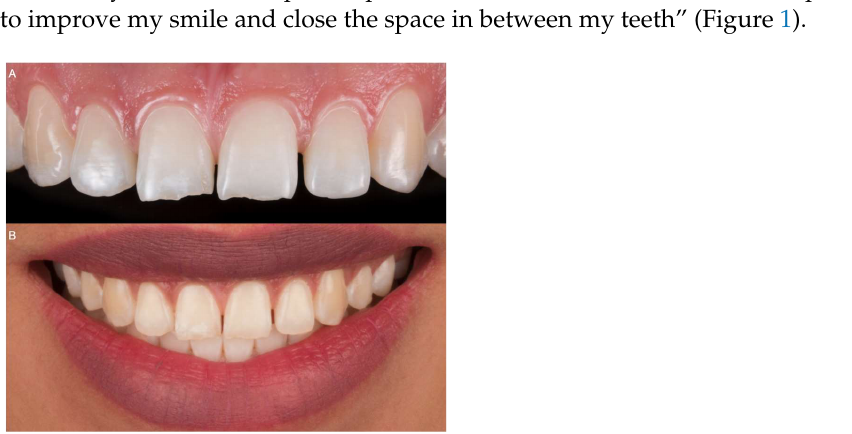
Figure 1. Frontal view of the initial situation. ( A ) Maxillary intraoral aspect. ( B ) Extraoral smile.